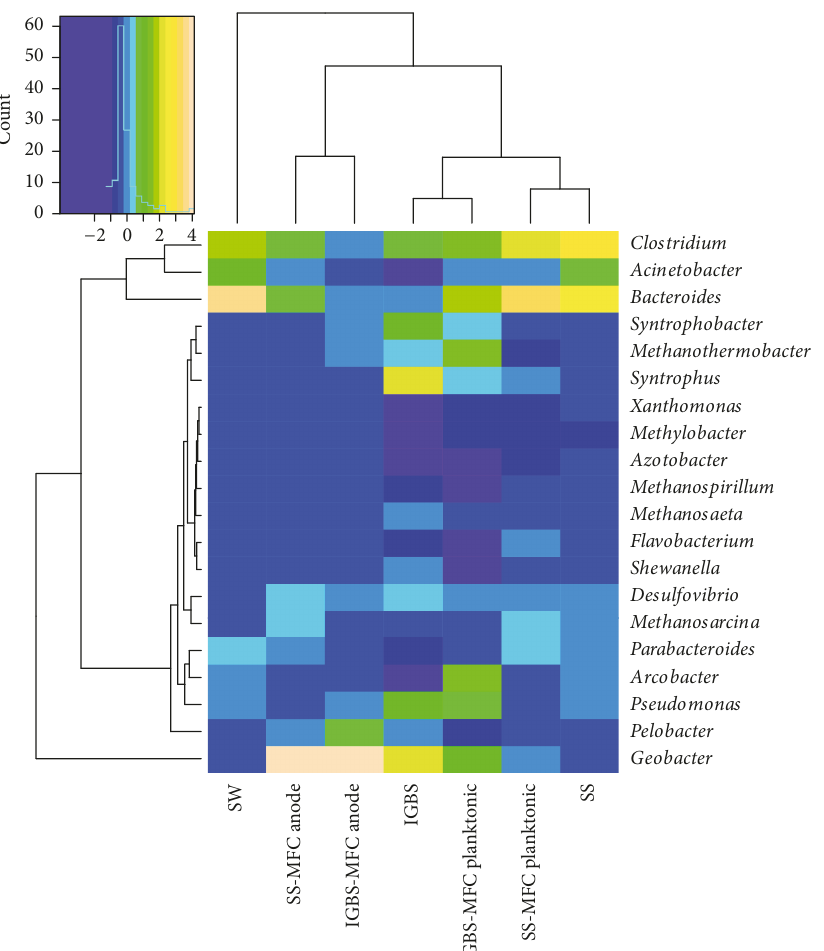
Figure 4: Heat map diagram visualizes the dominant bacterial and archaeal genera in the microbial community profiles. Bottom represents the different